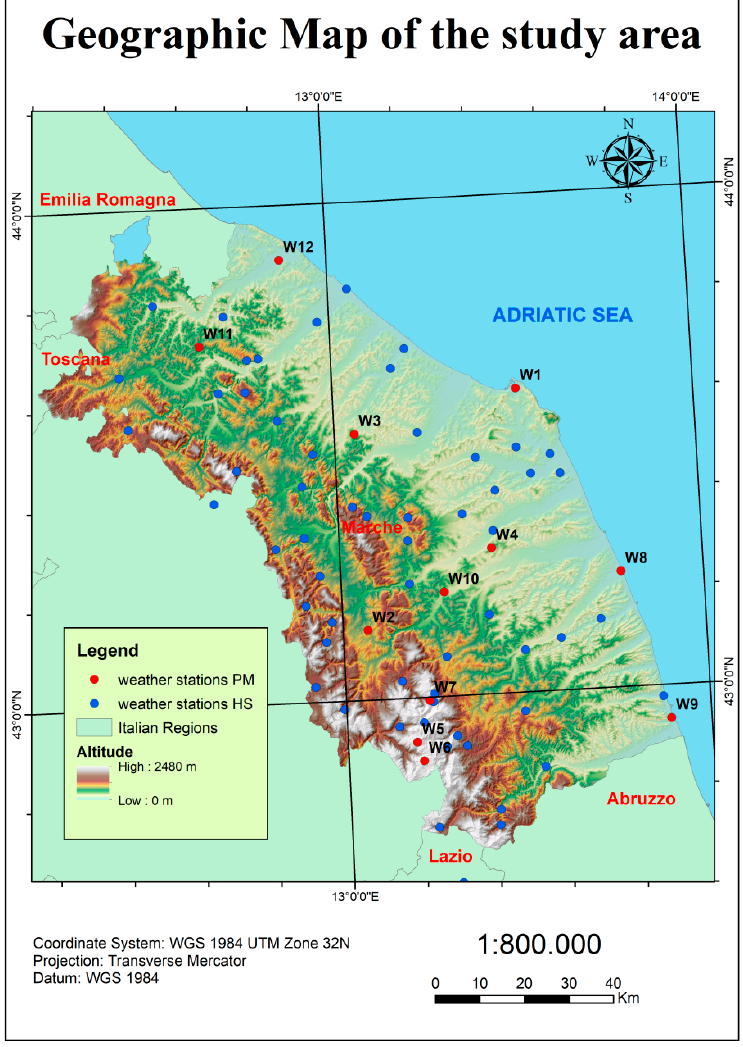
Figure 1. Geographical map of the study area; the weather stations that have all the parameters for the calculation of the ET0 with the PM method are highlighted with a red circle Ancona (W1), Camerino (W2), Colle di Montecarotto (W3), Macerata (W4), Monte Bove (W5), Monte Prata (W6), Pintura di Bolognola (W7), Porto Sant’Elpidio (W8), San Benedetto del Tronto (W9), Tolentino (W10) 228 m.a.s.l., Urbino (W11), Villa Fastiggi (W12), while the others that are calculated with the HS method are shown in blue.